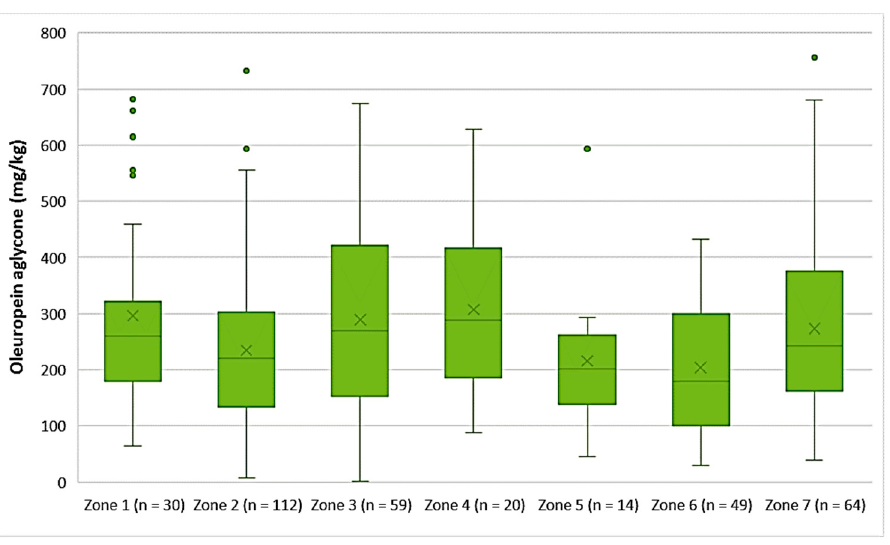
Figure 8. Concentration of oleuropein aglycone (mg/kg) in EVOOs from the seven zones (Zones 1–7) of the island of